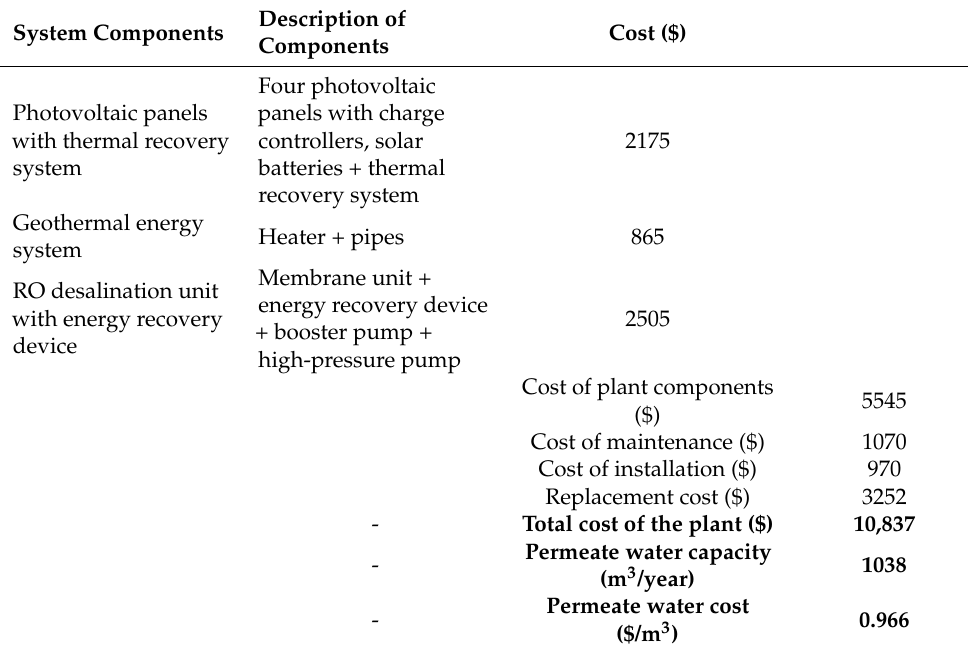
Table 2. Details of the cost of the proposed